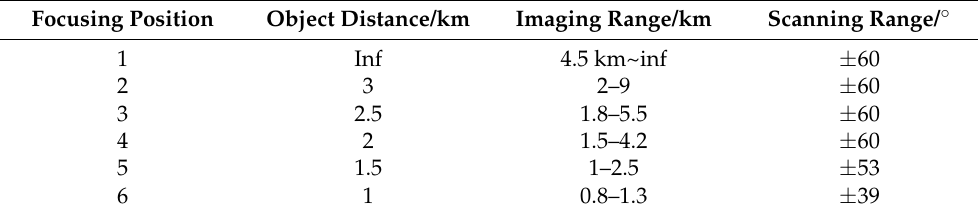
Figure 7. MTF curves of the optical system at different object distances after focusing on 1 km object distance: ( a ) 0.8 km object distance; ( b ) 1.3 km object distance.